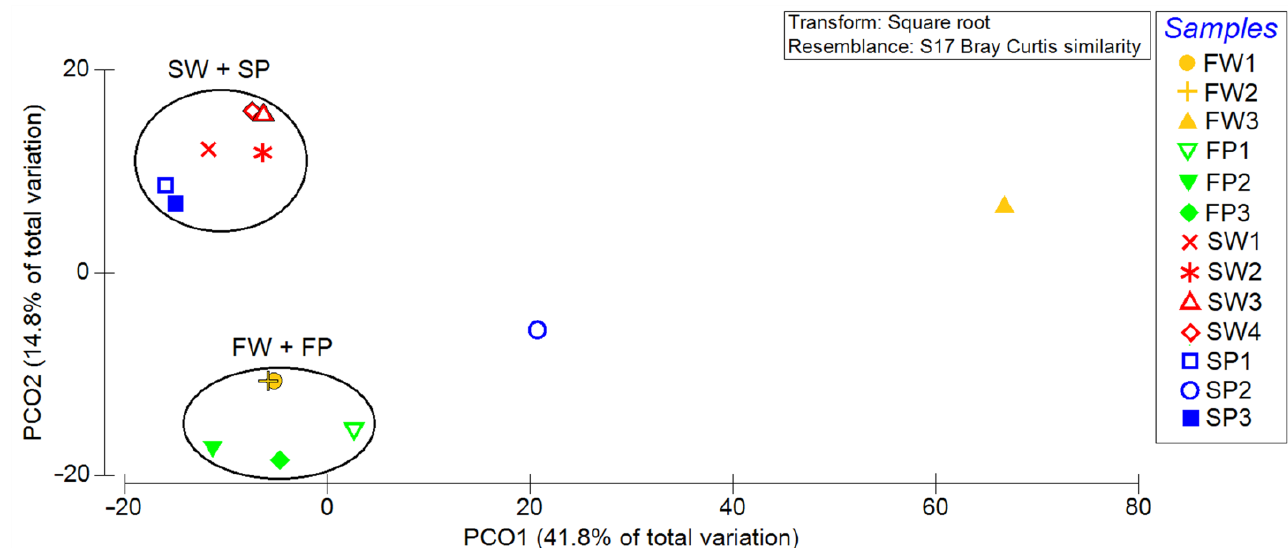
Figure 3. Principal coordinate analysis (PCoA) plot highlighting the clustering of microbiome samples. SW, FW, SP, and FP stand for seawater, freshwater, seawater PE, and freshwater PE, respectively. Samples FW3 and SP2 are not reported.